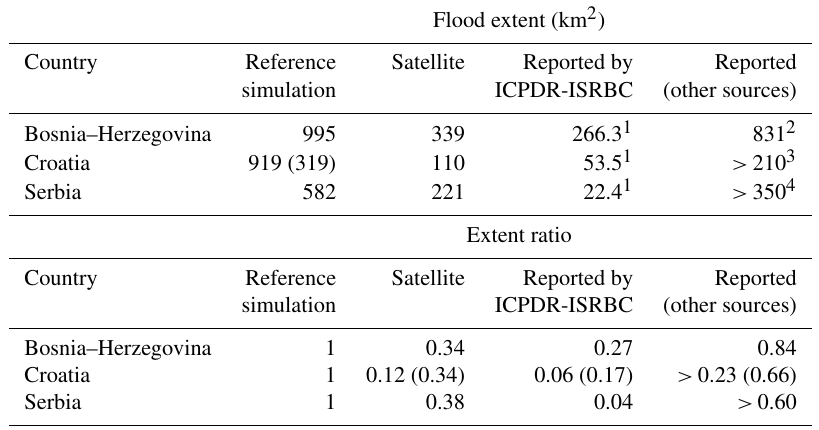
Table 2. Comparison of observed and simulated flood extent data at country scale. Satellite flood extent refers to Copernicus EMS maps. Values in parentheses for Croatia refer to a modified simulation, as explained in the text.